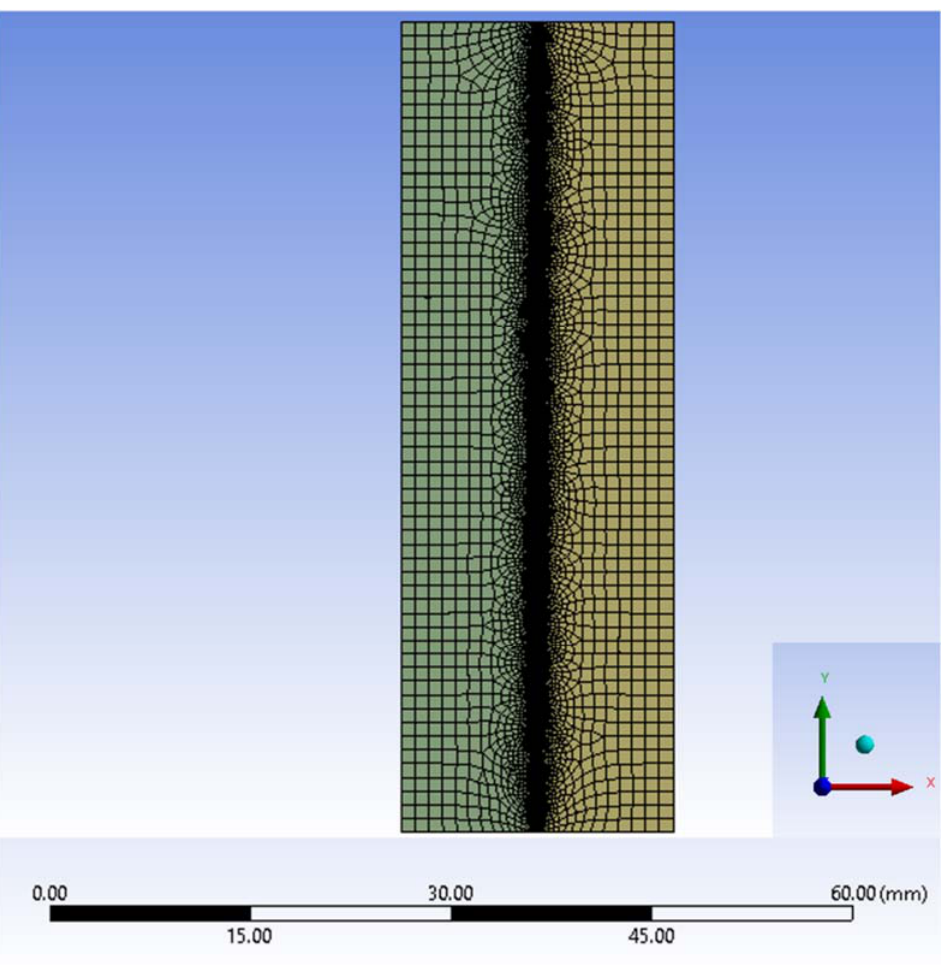
Figure 7. Mesh distribution for the LW FEA